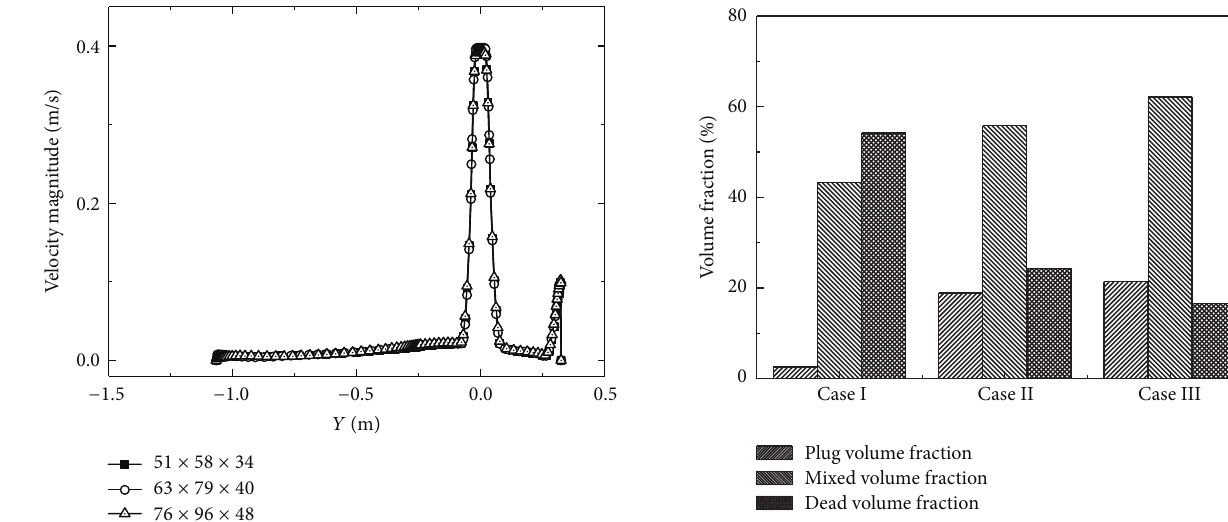
Figure 5: Grid independence check of solutions in a bare tundish.